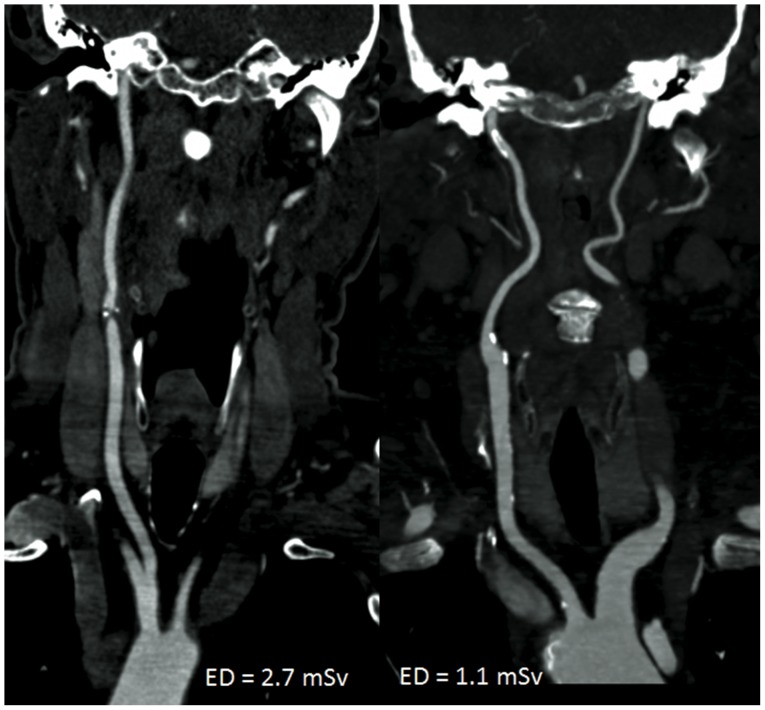
Comparison of image quality in two patients with suspected stenosis of the internal carotid artery.Curved planar reconstructions of (A) the standard protocol and (B) the low-dose protocol demonstrate similar diagnostic image quality in both protocols with a more smoothed appearance and reduced image noise at the level of the common carotid arteries using SAFIRE. Significantly lower radiation dose at B.